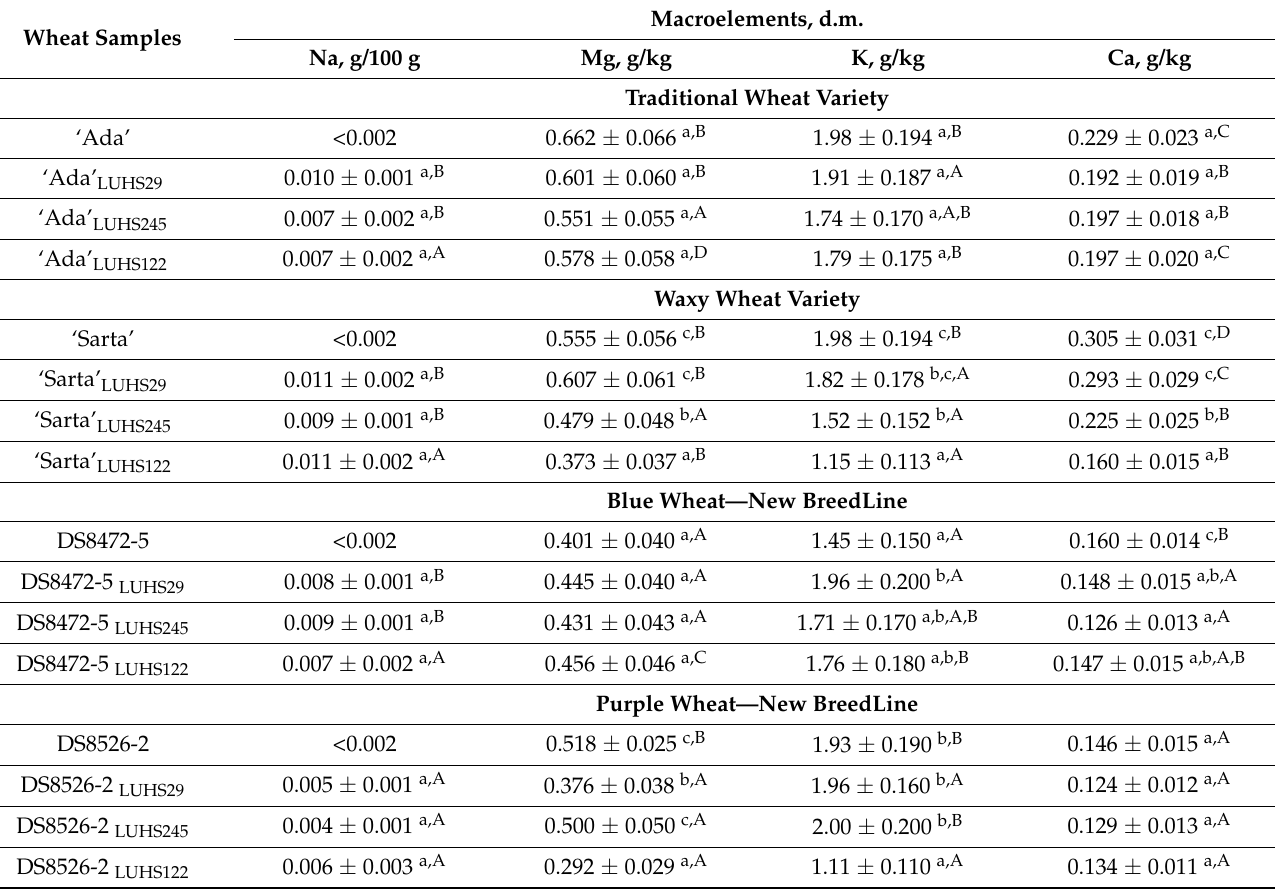
Table 3. Macroelement concentrations in wheat wholemeal